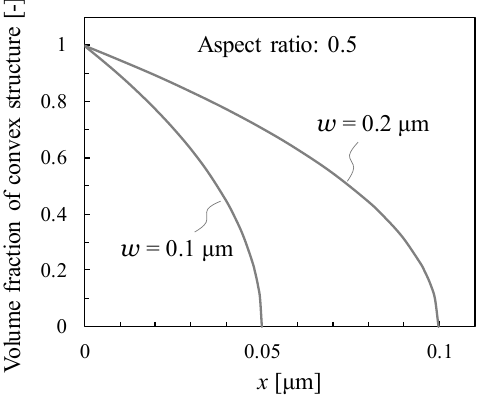
Figure 6. Volume fraction of a convex structure with surface normal ( x -axis) direction.